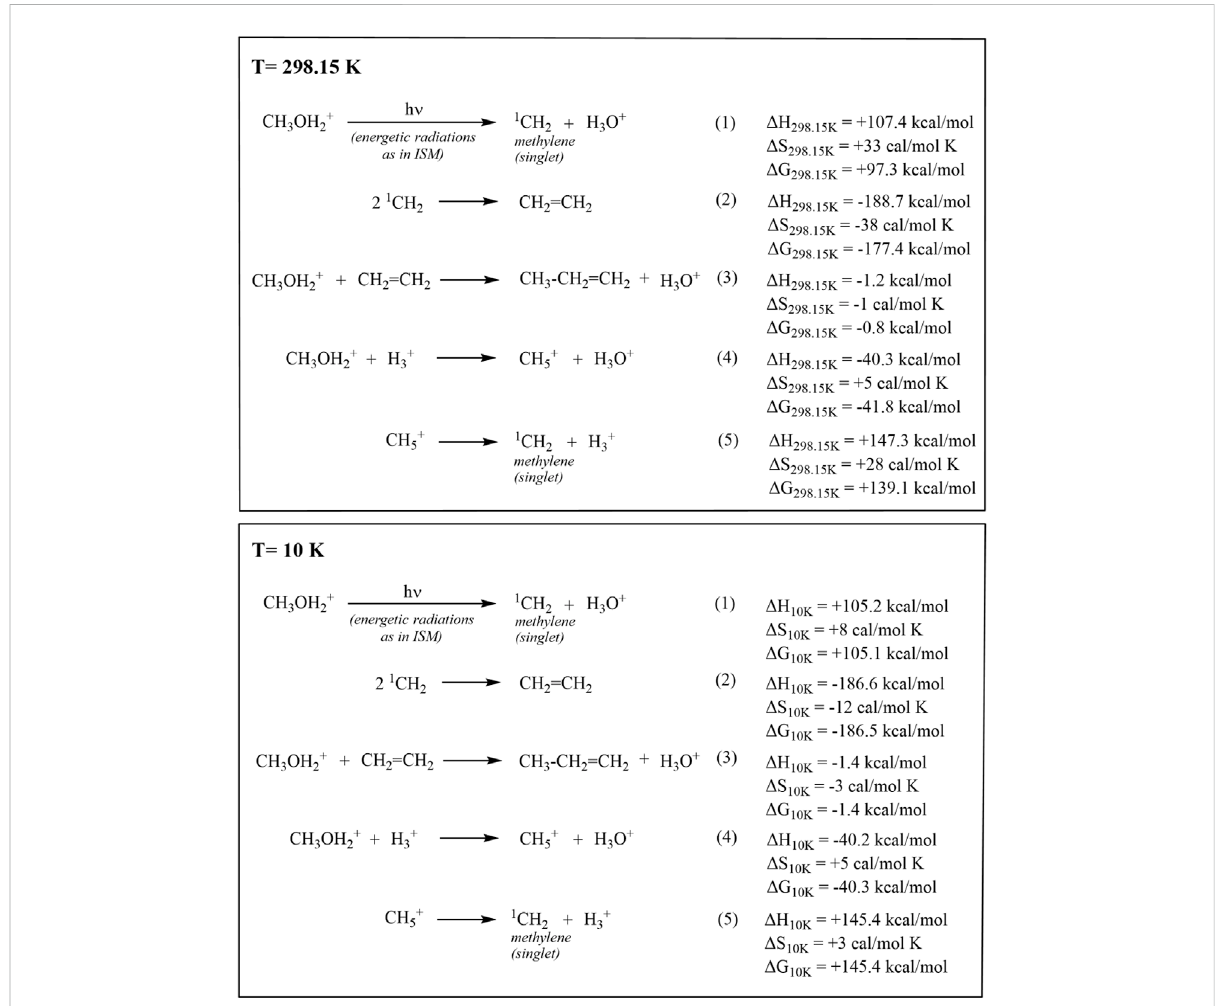
FIGURE 2 Probable pathways involved in the formation of ethylene and propylene by the “ Astrochemical methanol to ole fi ns (AMTO) ” process in the ISM, the comparison of thermodynamic parameters at 298.15 and 10 K.